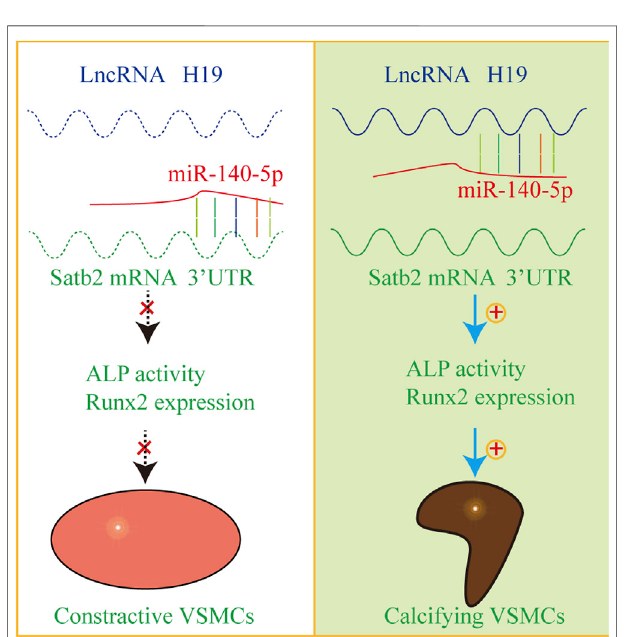
FIGURE 7 | The mechanism diagram about H19/miR-140-5p/Satb2 axis in the regulation of osteogenic differentiation of VSMCs. Normally, miR- 140-5p antagonizes the expression of Satb2 to inhibit osteogenic differentiation ofVSMCs inabsenceofH19.However, overexpressionof H19canspongemiR-140-5pandreleaseSatb2.Asaresult,VSMCsundergo phenotype transition into calcifying VSMCs and induce vascular calci fi cation.